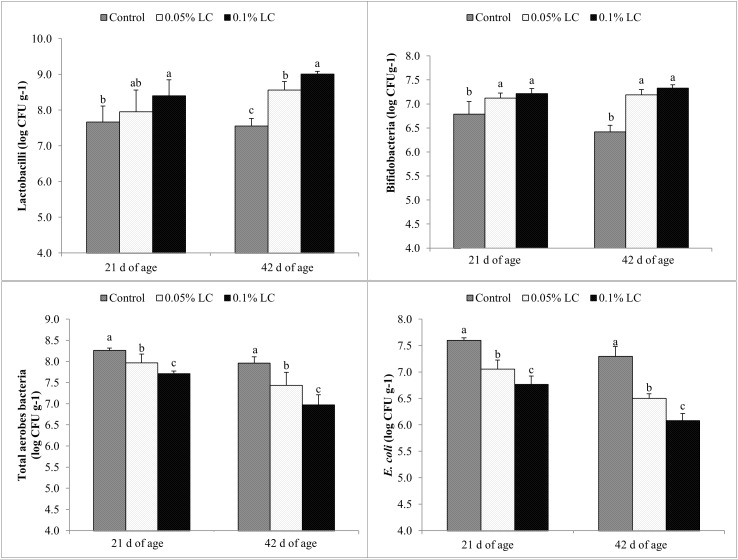
Effects of dietary supplementations of a mixture of three L. salivarius strains (LC) on populations of cecal lactobacilli, bifidobacteria, total aerobes and E. coli of broiler chickens at 21 and 42 d of age enumerated using the conventional spread plate method and expressed as log10 CFU g-1.Columns represent means of six birds in each treatment group (one chicken per replicate cage) ± SD. Within each period, columns with different letters differ significantly (P < 0.05). Control, basal diet; 0.05% LC, basal diet + 0.5 g kg-1 LC; 0.1% LC, basal diet + 1 g kg-1 LC.